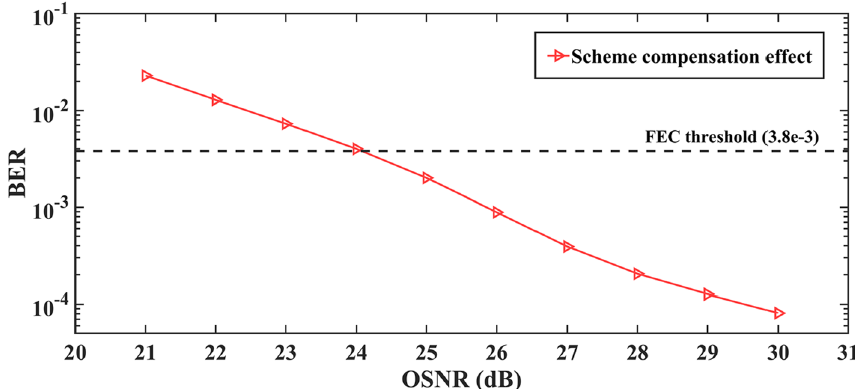
Fig. 6 BER performance with different OSNR